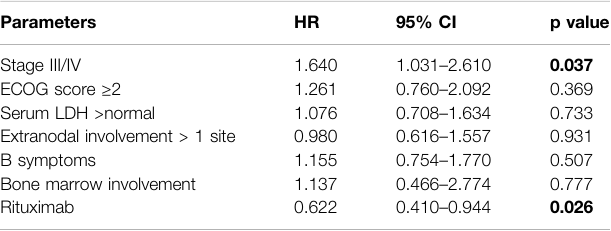
TABLE 6 | Summary of treatment-related adverse events